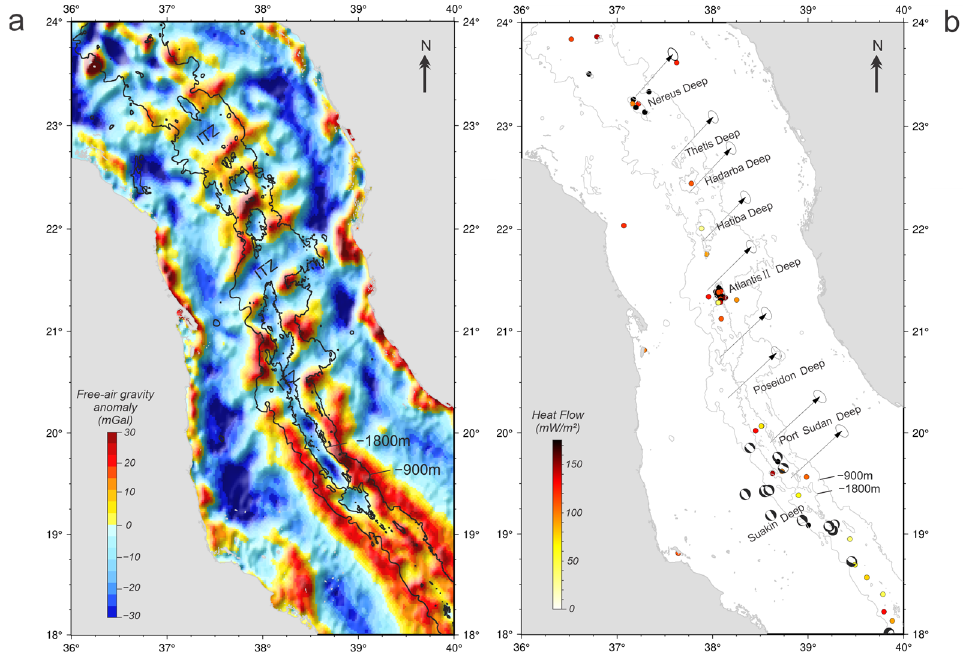
Figure 12. Geophysical and kinematic characteristics of the Central Red Sea Rift. ( a ) Free-air gravity anomalies of the Central Red Sea Rift [98]. Black lines along the rift axis indicate the isobaths of − 900 m and − 1800 m. ( b ) Plate kinematic, heat flow, and earthquakes in the Central Red Sea Rift. Black arrows represent relative motion angular velocities between the Nubia and Arabia, calculated according to the model MORVEL [40]. Grey lines indicate the isobaths of − 900 m and − 1800 m. Focal mechanism solutions of the earthquakes from 1976 to present are from the CMT catalog [99,100]. Dots are heat flow sites [101].